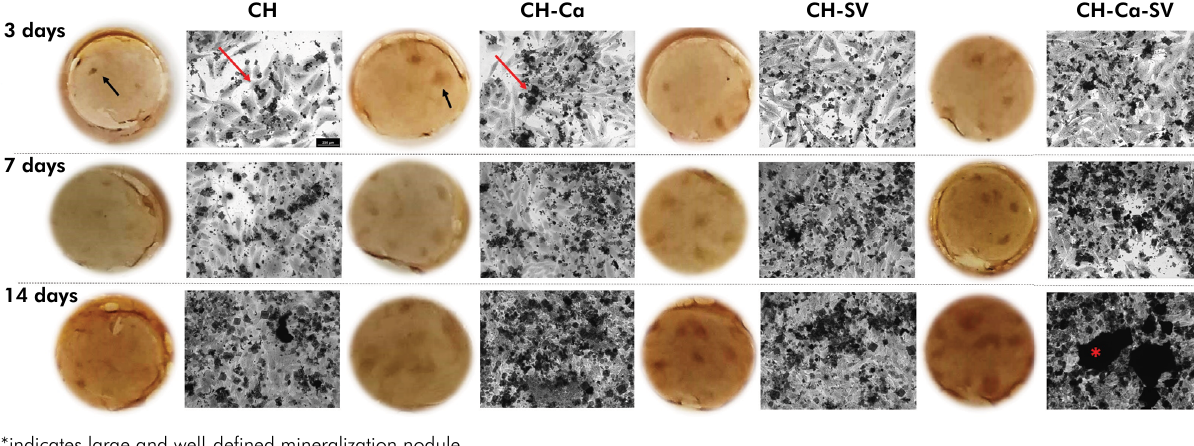
*indicates large and well-defined mineralization nodule. Figure 6. Representative images of the Alizarin Red assay. Black arrows indicate nodules observed on digital pictures of wells. Red arrows indicate small mineralization nodules on microscopic images (20x